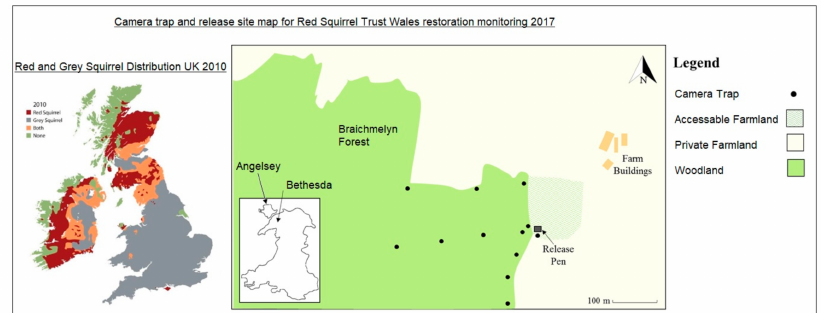
Figure 1. Camera-trap locations within the forest area of the Ogwen valley alongside current red squirrel distribution across the UK. Traps are marked with • , and the original release pen is marked with a square; traps were set 100 m apart from each other, away from the release pen. British red squirrel distribution shown in red, grey squirrel distribution in grey, shared zones in orange and green showing no population of either species